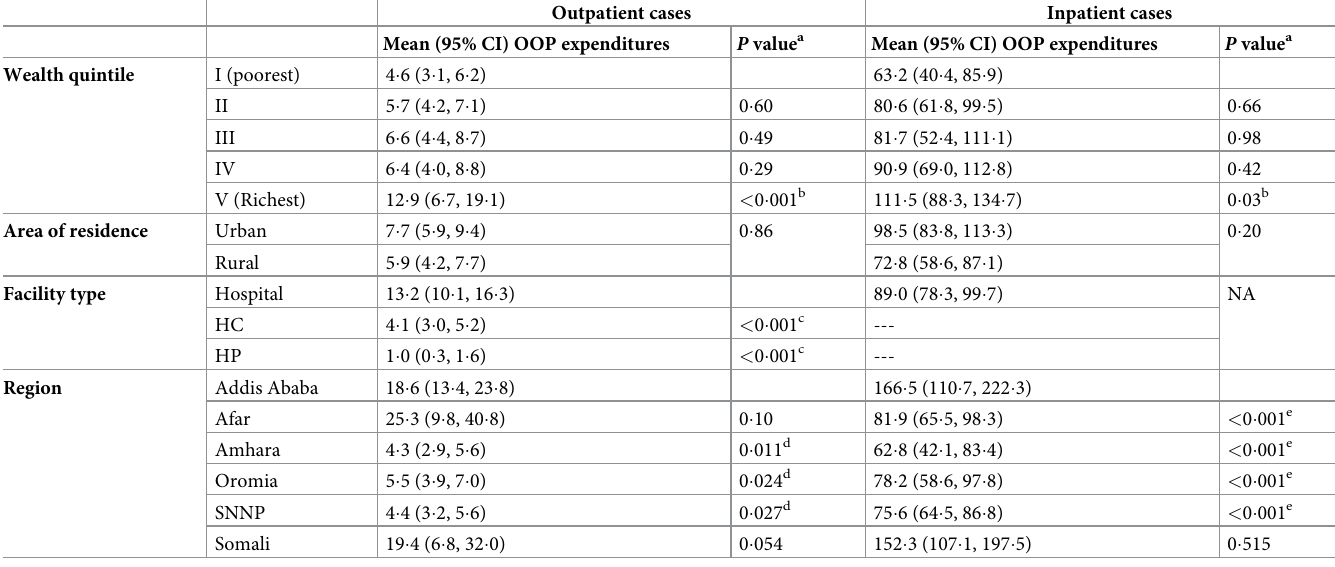
Table 2. Association between OOP medical expenditures and wealth quintile, area of residence, facility type, and region, for either inpatient or outpatient cases (for all conditions combined).